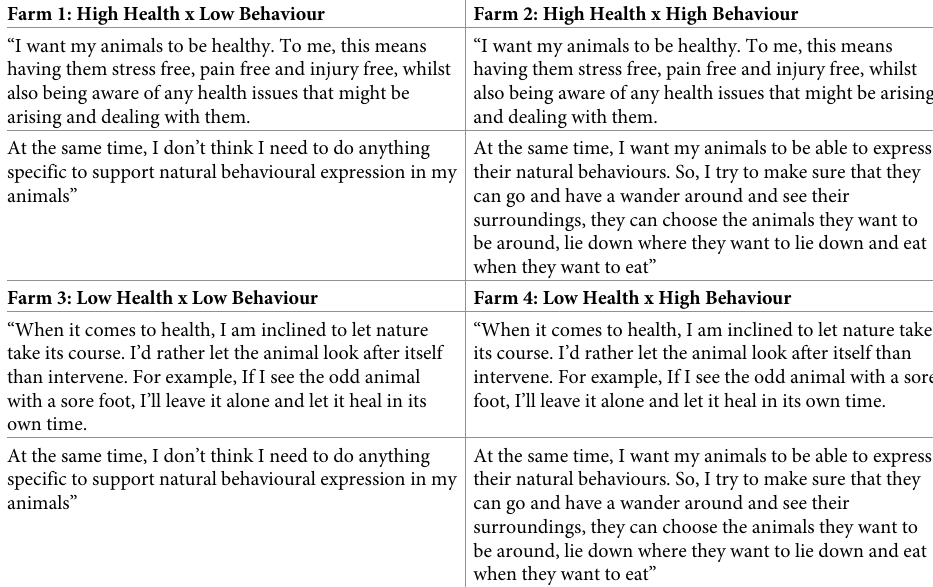
Farm 3: Low Health x Low Behaviour Farm 4: Low Health x High